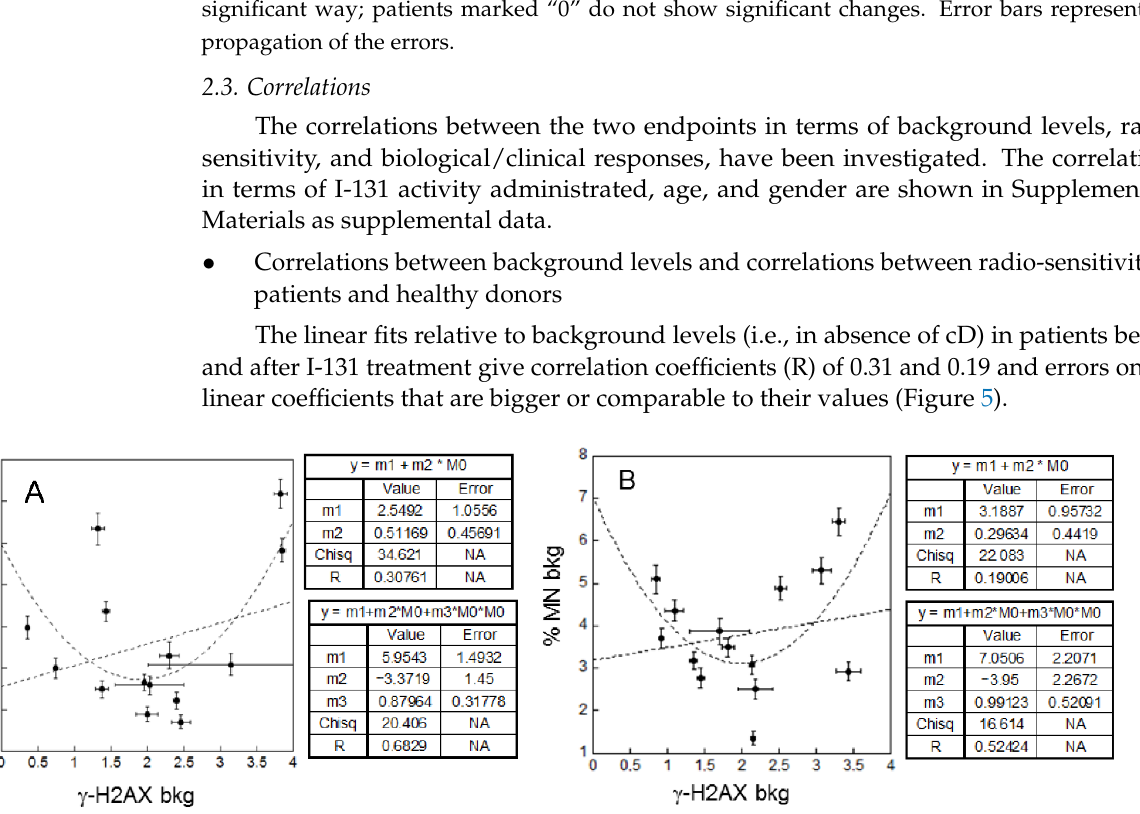
Figure 5. Background MN frequency versus the background level of γ-H2AX in patients, before ( A ) and after ( B ) I-131 treatment. The dotted lines represent linear or parabolic fits of the data. Error bars represent the propagation of the errors. Bkg: background.